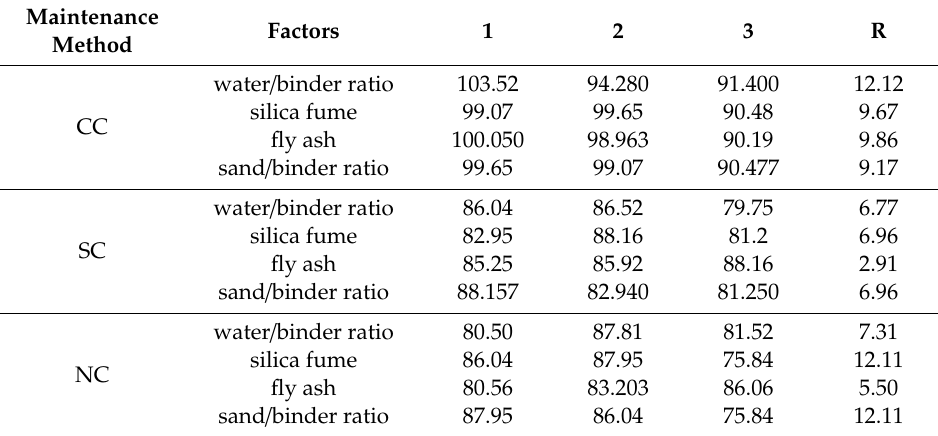
Table 9. Compressive strength range analysis.